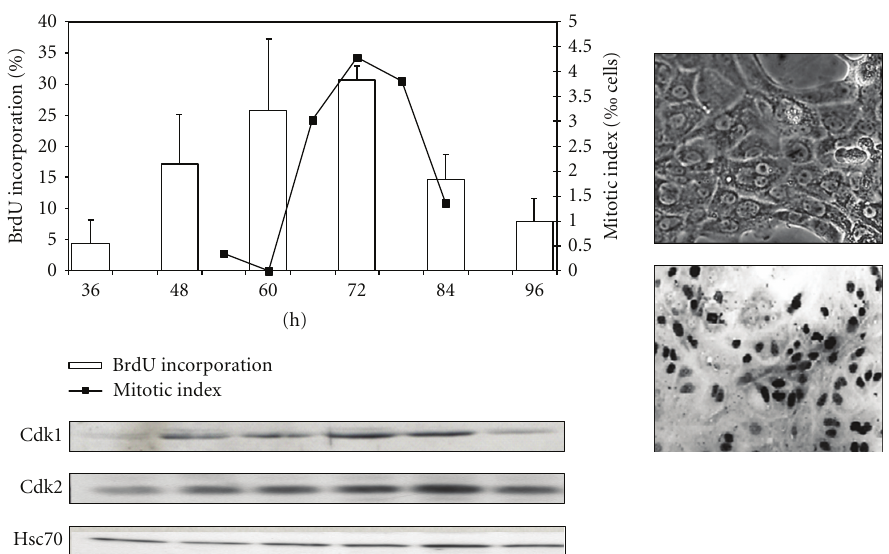
Figure 2: Proliferation of rat hepatocytes in pure culture. Isolated rat hepatocytes (right, picture in phase contrast) seeded at low density ( < 5.10 4 cells/cm 2 ) and stimulated with EGF (25ng/mL) commit to DNA synthesis (BrdU incorporation, histogram and in situ immunodetection of BrdU positive cells) and complete the cell cycle (mitotic index, right axis). Western blotting of Cdk1 and Cdk2 and the loading control